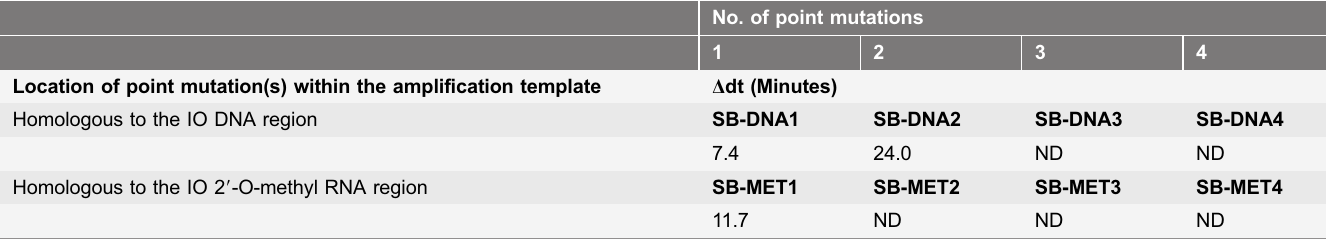
Table 1. Sensitivity of SIBA extension to point